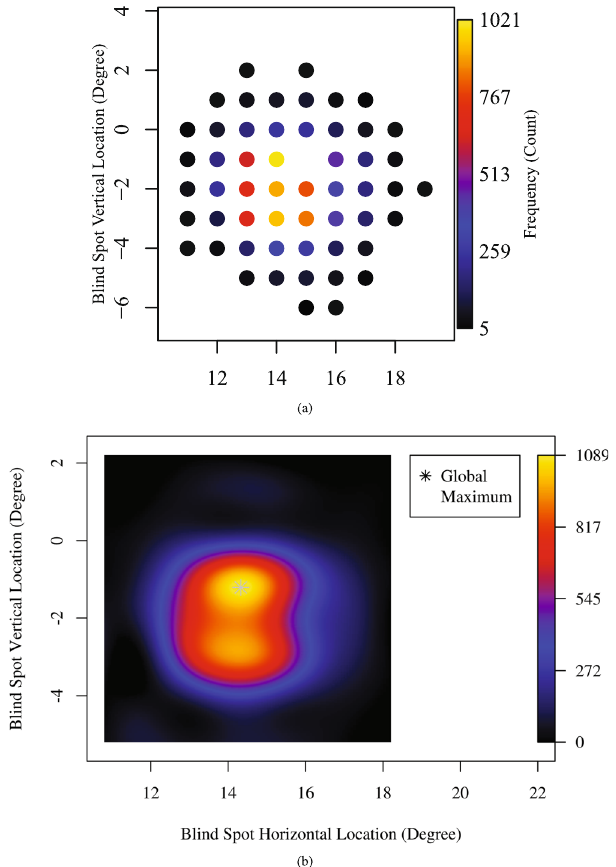
Figure 1. Blind spot distribution over location ( a ) discrete distribution of number of eyes measured at each NBSL and ( b ) continuous distribution of number of eyes at each NBSL calculated by Gaussian